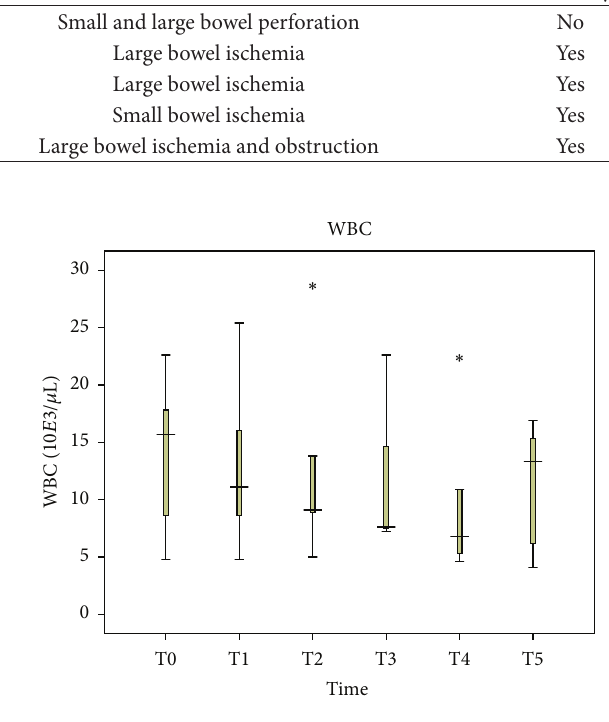
Figure 3: Perioperative white blood cells (WBC) levels in blood plasma.